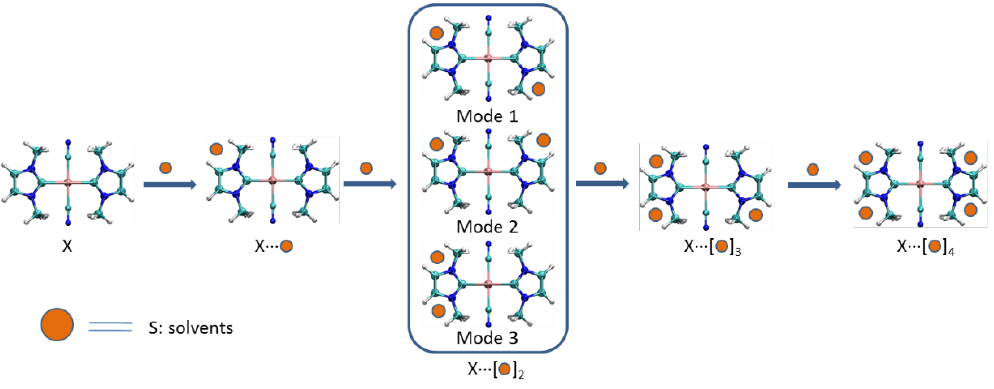
Figure 3. The model of complex formation between host clusters X (X = I, II, and III) and solvents (CH 3 OH, CH 3 CH 2 OH, and H 2 O).